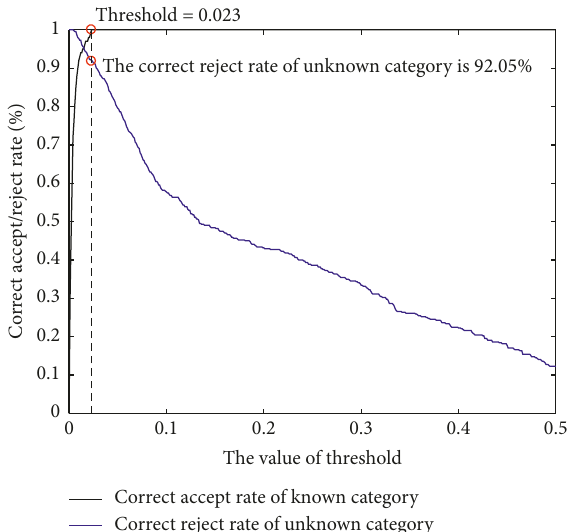
Figure 6: The relationship between threshold T and correct accept/ reject rate.